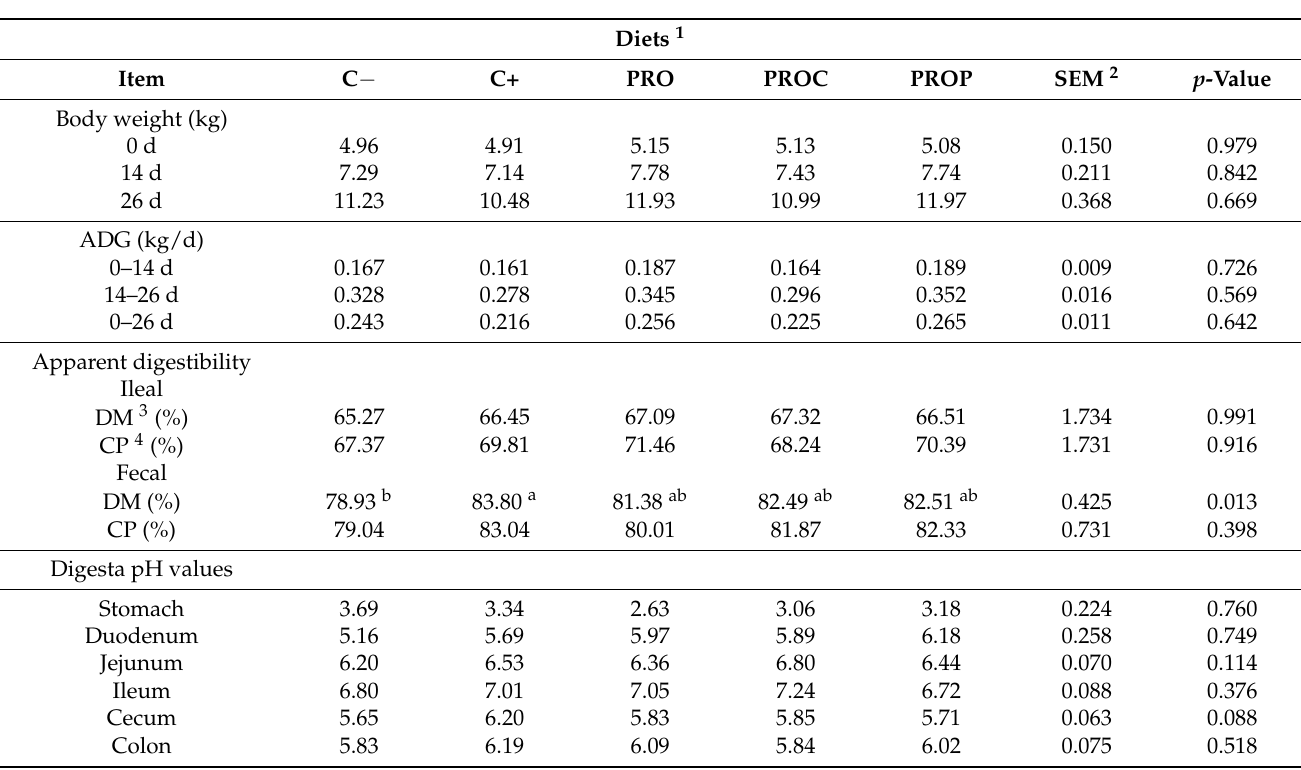
Table 2. Body weight, average daily gain (ADG), apparent ileal and fecal digestibility of dry matter and crude protein, and digesta pH values of piglets fed experimental diets.